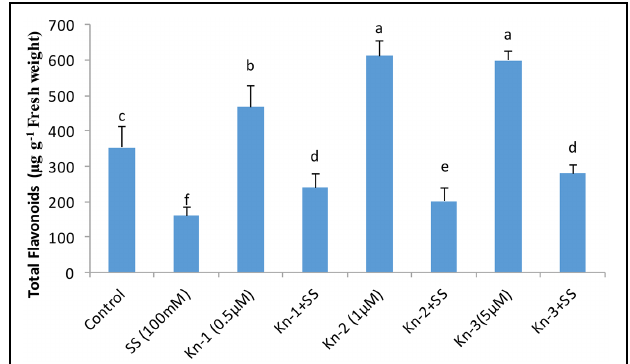
FIGURE 2 | Effect of Kn and salt stress on the concentrations of total flavonoids in soybean cv. Daewonkong. Bars in the graph represent means of three replicated with ± SEM. Bars labeled with same letter are not significantly different at P > 0.05 by Duncan Multiple Range Test (DMRT).